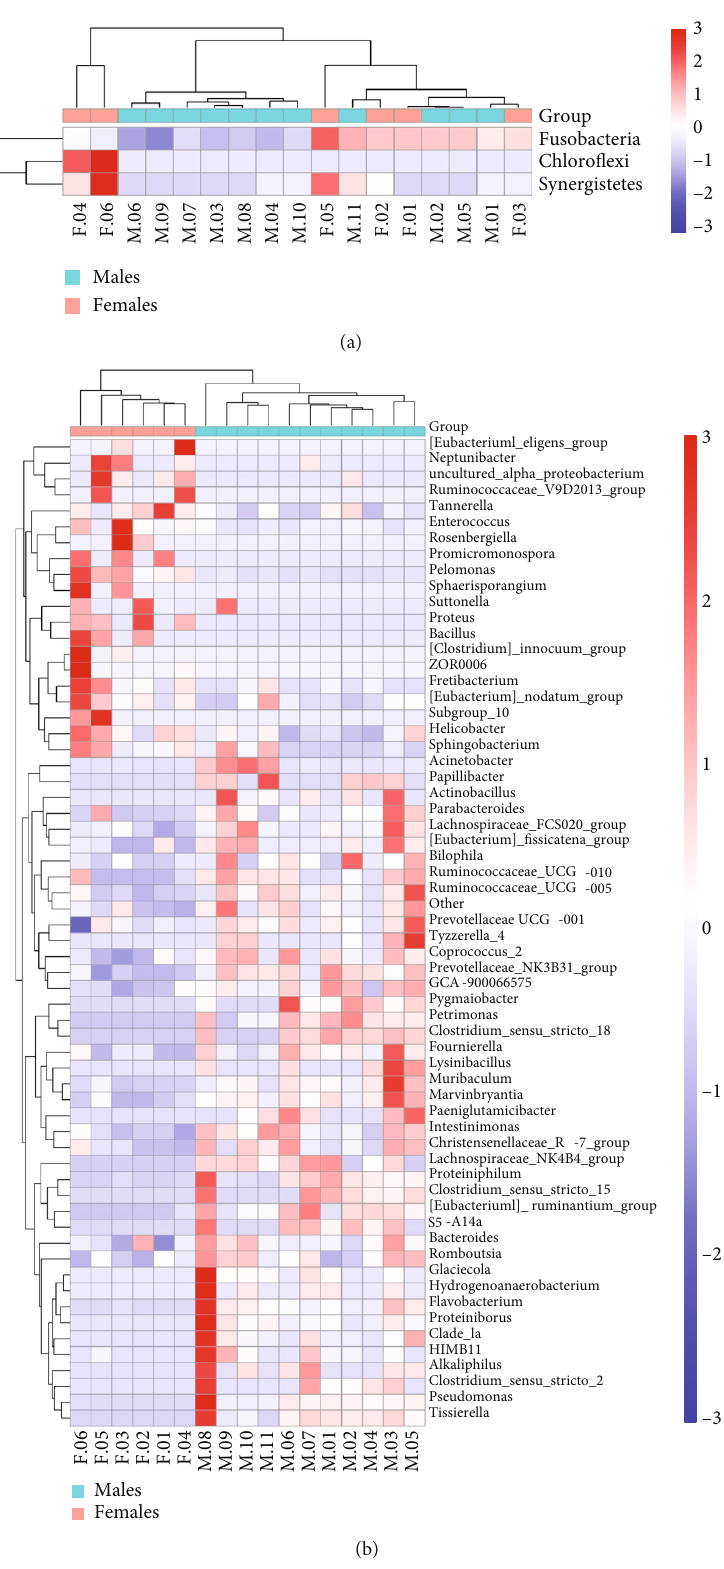
Figure 3: Heat map of the di ff erential oral microbiomes between young male and female patients with severe and advanced periodontitis. (a) Phylum level. (b) Genus level. The horizontal axis is the sample information (group and number), and the vertical axis is the species annotation. Colors indicate the Spearman rank